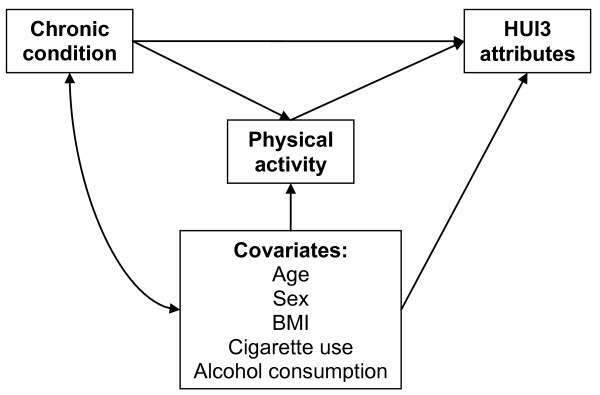
Heuristic diagram of hypothesized relationships.